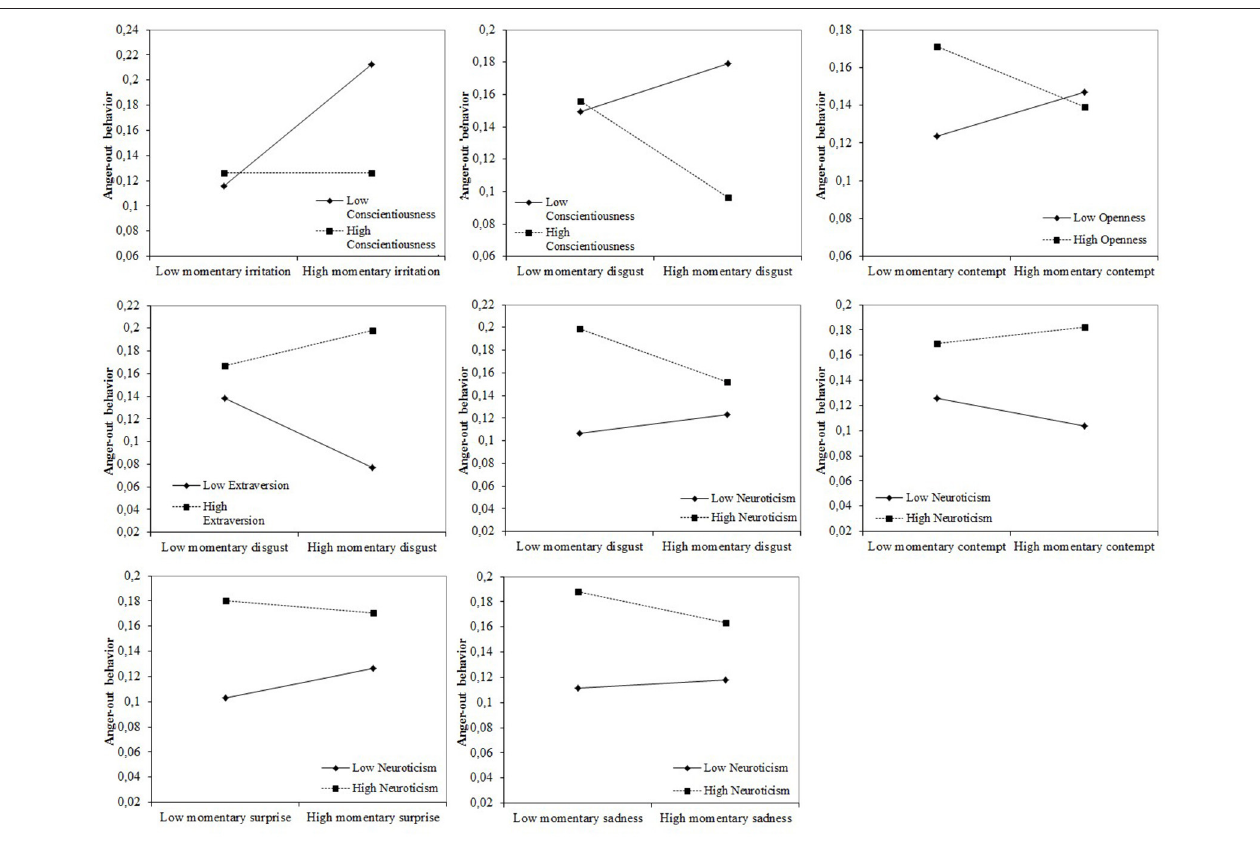
FIGURE 2 | Statistically significant interactions between momentary emotions and personality traits in predicting anger-out